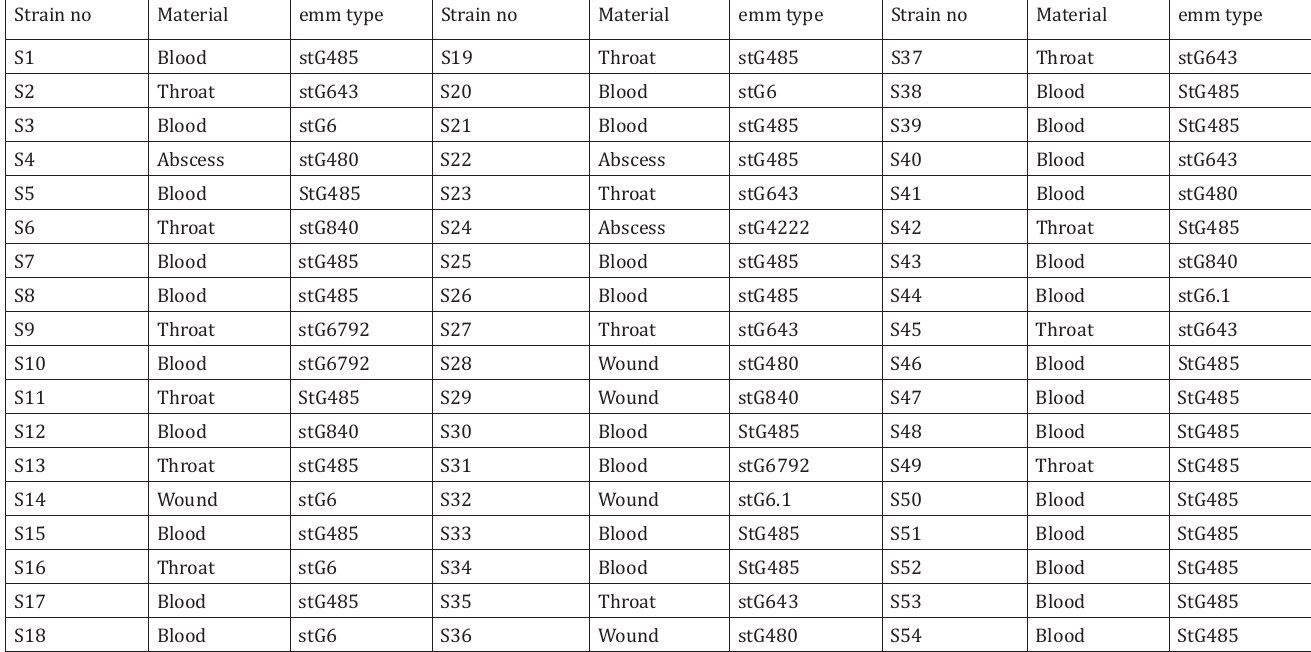
Distribution of SDSE strains according to their emm and material